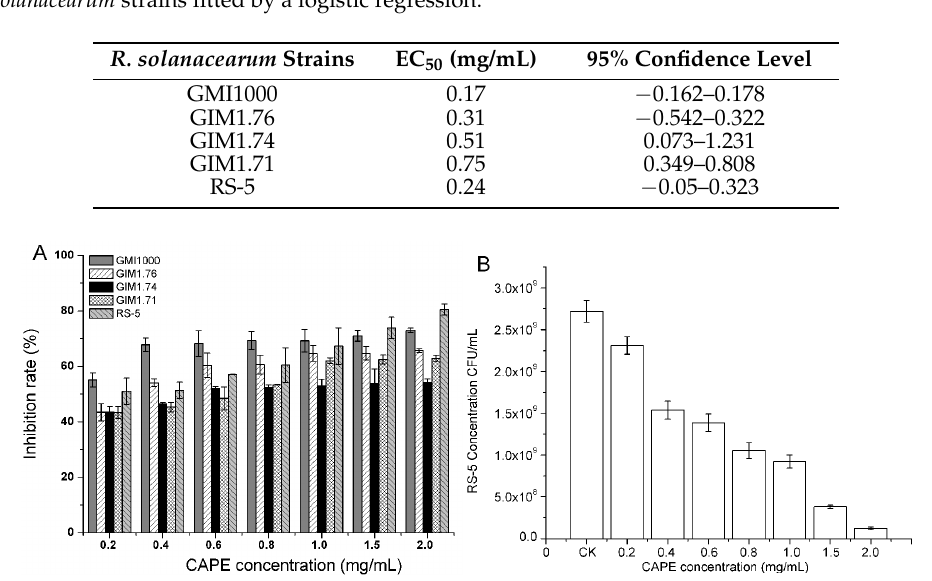
Table 4. Half maximal effective concentration (EC 50 ) (mg/mL) values of CAPE against five R. solanacearum strains fitted by a logistic regression.